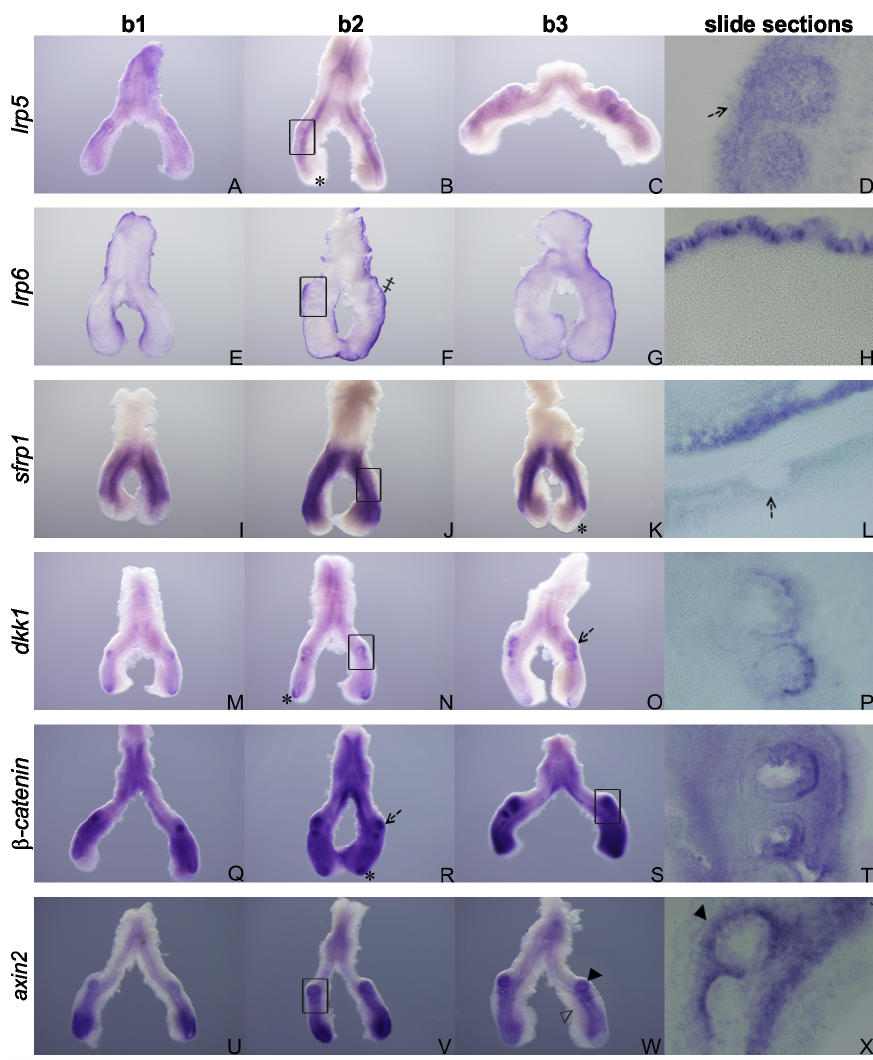
Figure 3. Wnt signaling members’ expression pattern in early stages of chick lung development. Representative examples of in situ hybridization of lrp5 (A–D), lrp6 (E–H), s frp1 (I–L), dkk1 (M–P), b -catenin (Q–T), axin2 (U–X) of stage b1, b2 and b3; n 5 15 per stage. Asterisk – epithelial tip of the main bronchus. Dark arrowhead – periepithelial mesenchyme of secondary buds. Double dagger – mesothelium. Dashed black arrow – secondary buds epithelium. Open arrowhead – medial mesenchyme. Magnification: whole mount, 5 6 ; slide sections, 20 6 . The black rectangle in images B, F, J, N, S and V indicate the region shown in corresponding slide